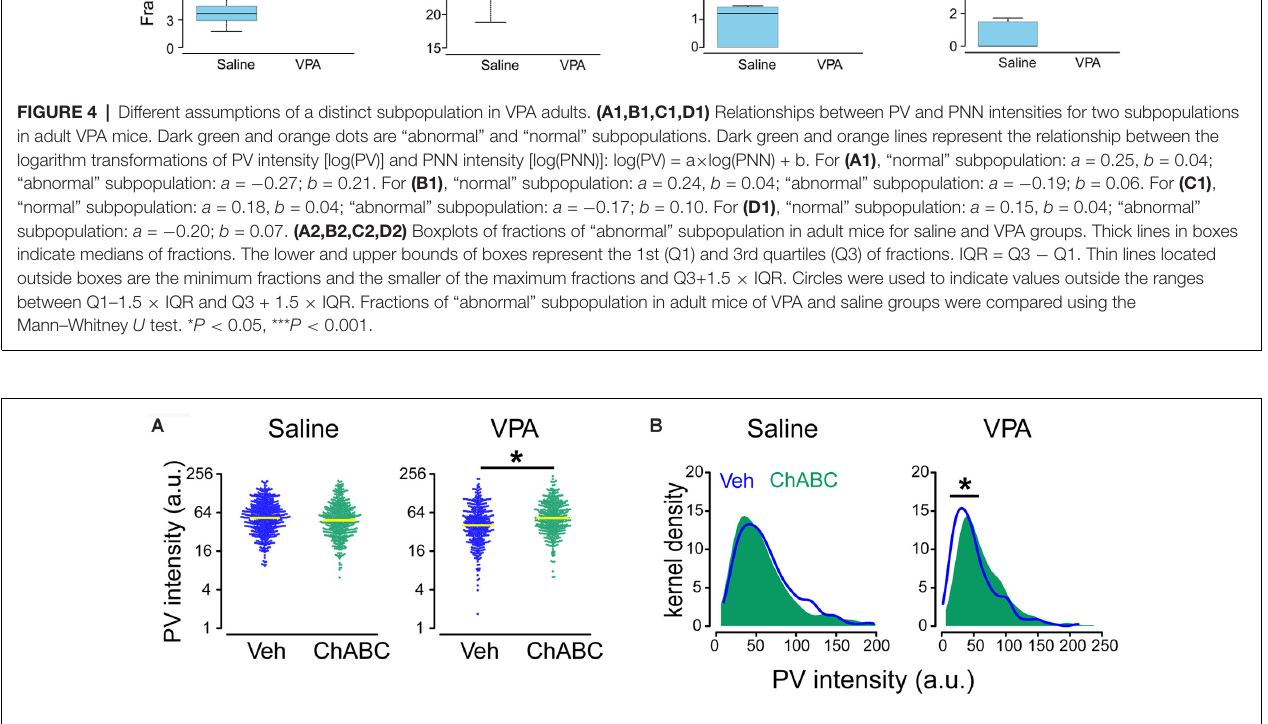
FIGURE 5 | Restored PV expression in ChABC-treated VPA adult mice. (A) Beeswarm plots of PV intensity from all neurons analyzed in saline and VPA mice treated by Veh and ChABC, respectively. (B) Kernel density estimation of PV intensity for all neurons analyzed in saline and VPA mice treated by Veh and ChABC, respectively. Yellow lines in panel (A) indicate geometric means of PV intensity. Linear mixed models were applied to compare the means of logarithm transformations of PV intensity [log(PV)] between groups using cells as the statistical units. Kolmogorov–Smirnov tests were employed to assess disparities in the distribution of PV intensity between groups using cells as the statistical units. N = 512, 448, 381, and 411 cells in Saline-vehicle, Saline-chABC, VPA-vehicle, and VPA-chABC groups, respectively. * P <